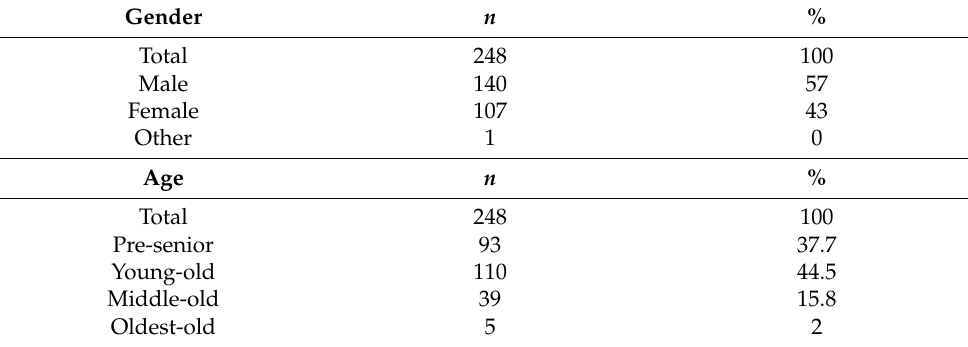
Table 1. Demographic characterization of the